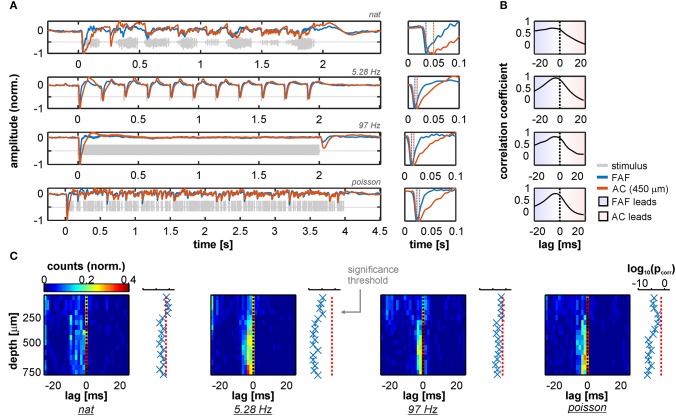
LFP stimulus-related activity in the frontal auditory field (FAF) precedes that of the auditory cortex (AC). (A)
Left column: Grand average across all 50 penetrations of LFPs recorded from the FAF (blue) and the AC at a depth of 450 μm (orange) in response to the four stimuli tested [ordered from top to bottom: natural sequence (nat), 5.28 Hz train, 97 Hz train, and the Poisson syllabic sequence (poisson); gray traces]. Right column: zoom into the first 100 ms after stimulus onset. Negative peaks in the evoked potential are marked with vertical dashed lines. Note that peaks in the FAF occur earlier than in the AC. (B) Cross-correlation between traces in A (left column). Peaks in negative lags indicate that FAF field-potentials lead those in the AC. (C) Peak lags from the cross-correlations between FAF LFPs and AC LFPs, for all penetrations (n = 50) and across recording depths. Next to each heatmap, log-scaled corrected p-values testing that the peak lag distribution is significantly below 0 (FDR corrected tailed Wilcoxon signed rank tests; pcorr < 0.05 for significance), across AC depths.